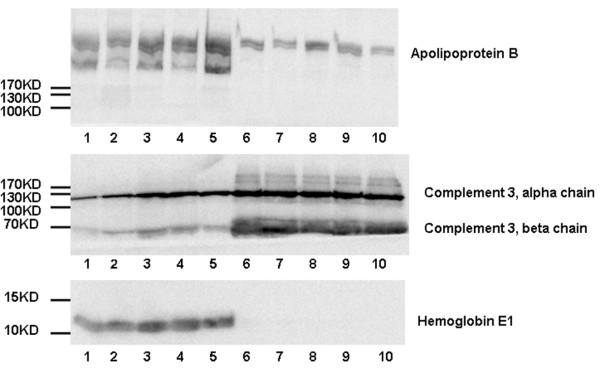
Validations of C3, HBE1, and Apolipoprotein B by Western blot. Western blot was performed to validate the changes in C3, HBE1, and Apolipoprotein B in five E15.5 fetus serum samples and five newborn rat serum samples. Thirty micrograms proteins of each specimen were loaded per lane. Lanes 1–5 indicate different E15.5 fetuses and lanes 6–10 indicate different newborn rats.